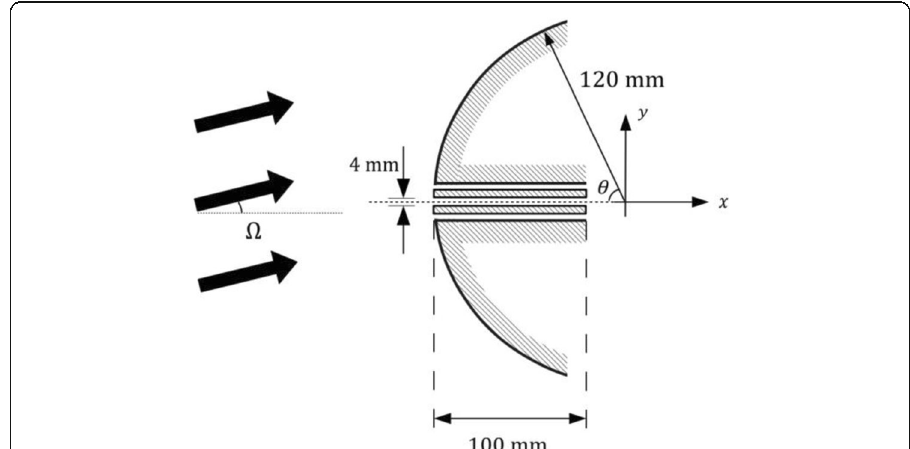
corresponding to the Euler equations is computed as a convex combination of three parts, namely F A , F D and F C , in the original scheme. The F A is dissipative and F D and F C are less dissipative. The arguments of F A and F D are computed by MUSCL (the van-Leer slope limiter) and those of F C are done by fifth order accur- ate Lagrange ’ s polynomial approximation. The weights of the convex combination vary smoothly according to physical situations such that F A , F D and F C , respect- ively, become dominant around shock waves, around contact discontinuities and in smooth regions. The Euler flux of the simplified scheme comprises F A and F D ; the former takes charge of regions around shocks and the latter does of those around contact discontinuities and smooth regions. The diffusive numerical flux is com- mon for both of the schemes and is computed by the standard second order accur- ate central finite difference approximation; second order accuracy is considered to suffice even in the original scheme in view of the smallness of the diffusive terms, which are multiplied by the inverse of the Reynolds number. The standard RK-4 and RK-2 are employed in the original scheme and the simplified one,